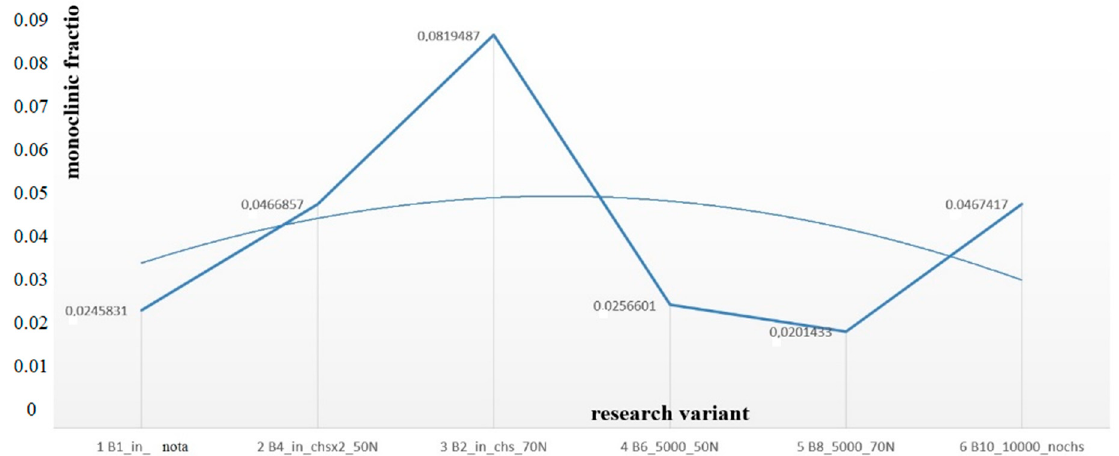
Figure 7. Monoclinic contents of Vm in zirconia material depended on research variables.